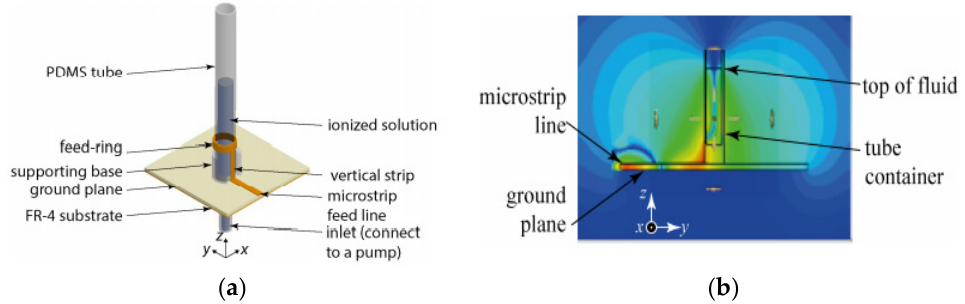
Figure 18. ( a ) Isometric sight of the 3D-printed monopolar fluidic antenna; ( b ) simulated H-field at 3.5 GHz [47].